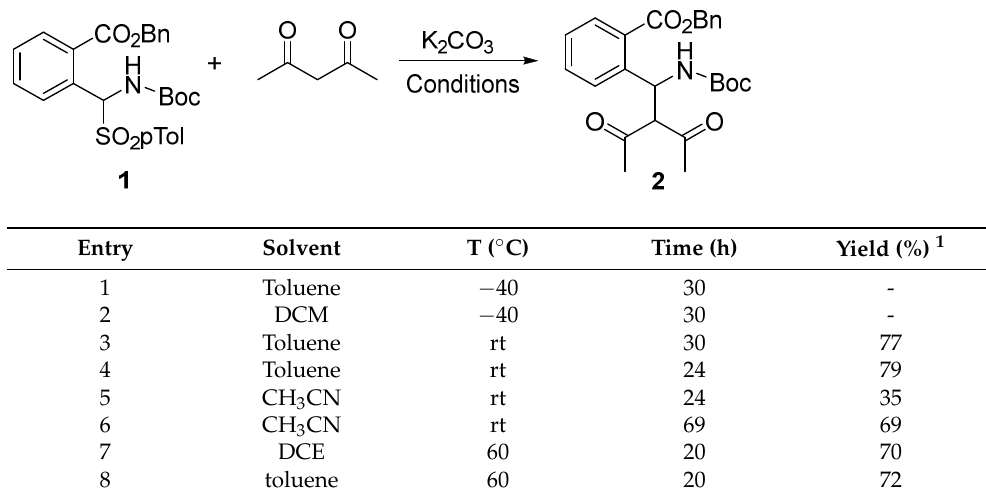
Table 2. Control experiments under achiral conditions.